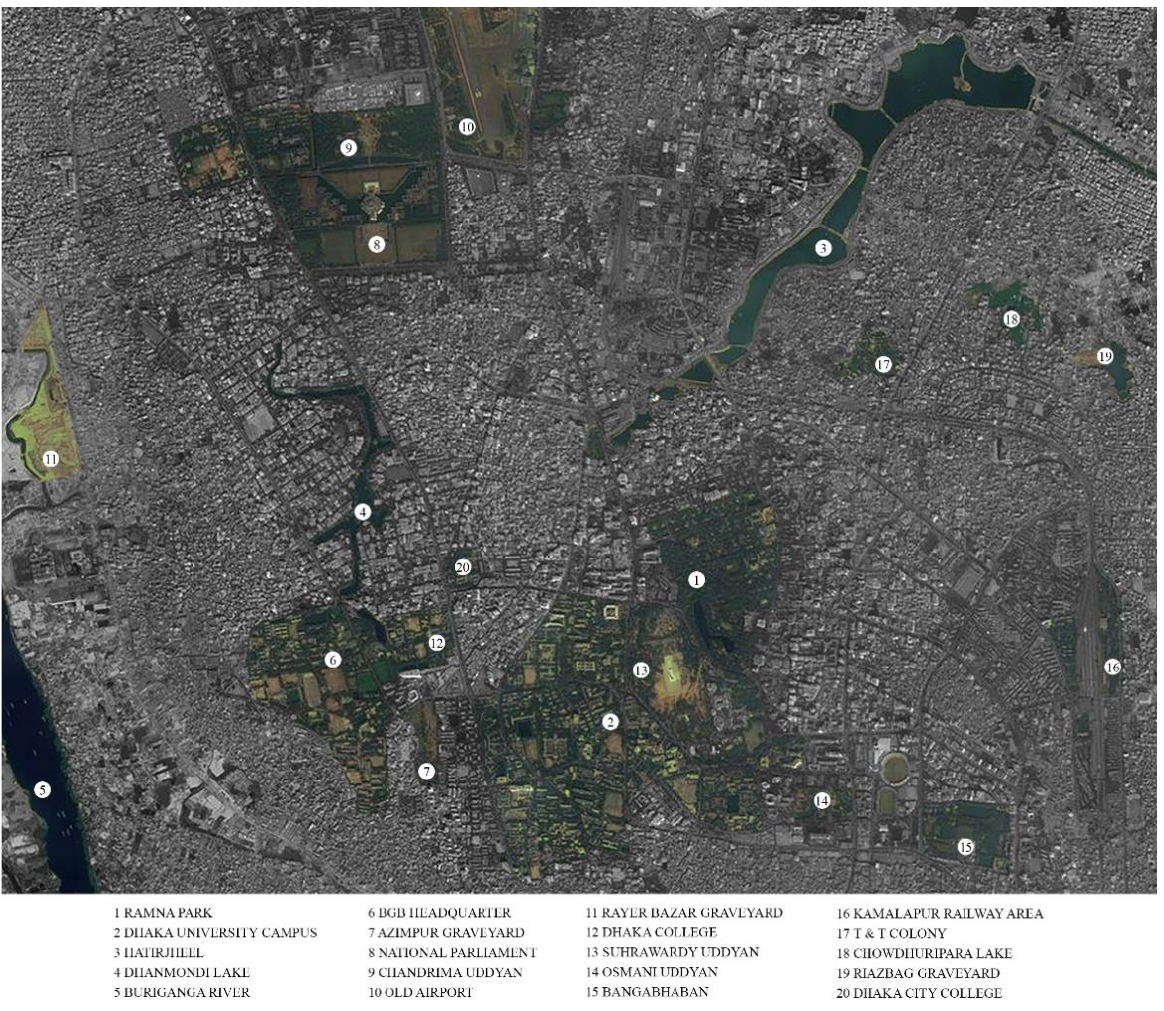
Figure 1: A few of the green areas in Dhaka. Even without considering how healthy the ecosystem is there, the small quantity of isolated green areas in comparison with the grey ones is highly noticeable. Image source: Bing